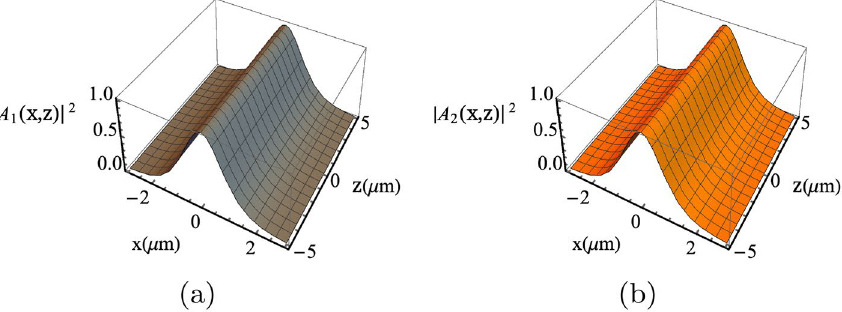
Figure 6. Solitons profile considering period length a as in Fig.